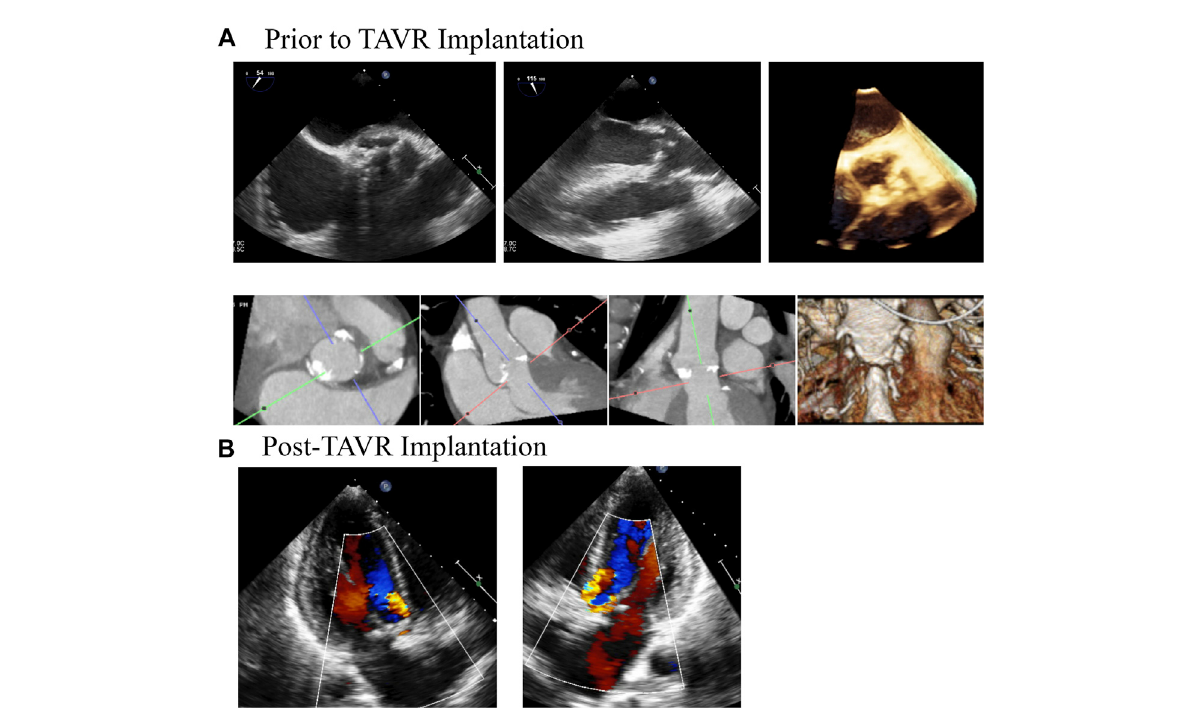
FIGURE 1 Medical Imaging of Patients Aortic Valve Demonstrates Clinically Signi fi cant Paravalvular Post TAVR Implantation. A patient was referred for TAVR for severe aortic stenosis. (A) demonstrates TEE and CT imaging of the aortic prior to the procedure. The patient had trace aortic insuf fi ciency prior to the procedure. Following the procedure (B) , the patient was found to have moderate paravalvular regurgitation that persisted for at least 1 year following the procedure, as demonstrated by the follow up